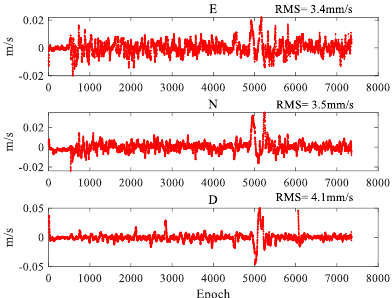
Figure 7 . GNSS observation residual of GNSS/INS tightly